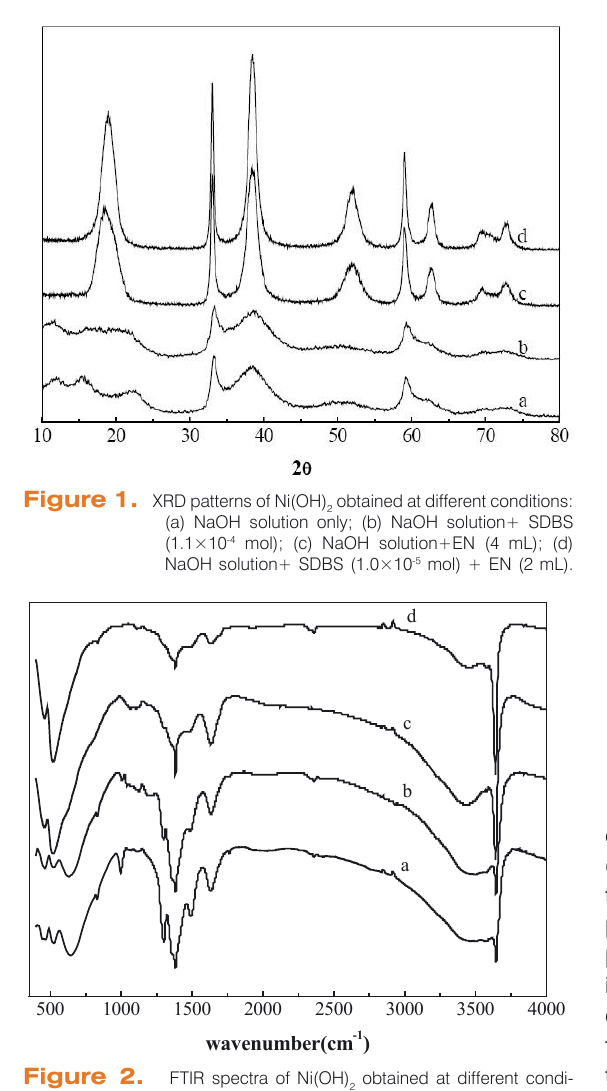
FTIR spectra of Ni(OH) obtained at different condi- 2 tions: (a) NaOH solution only; (b) NaOH solution+ SDBS (1.1×10 -4 mol); (c) NaOH solution+EN (4 mL); (d) NaOH solution+SDBS (1.0×10 -5 mol)+ EN (2 mL).